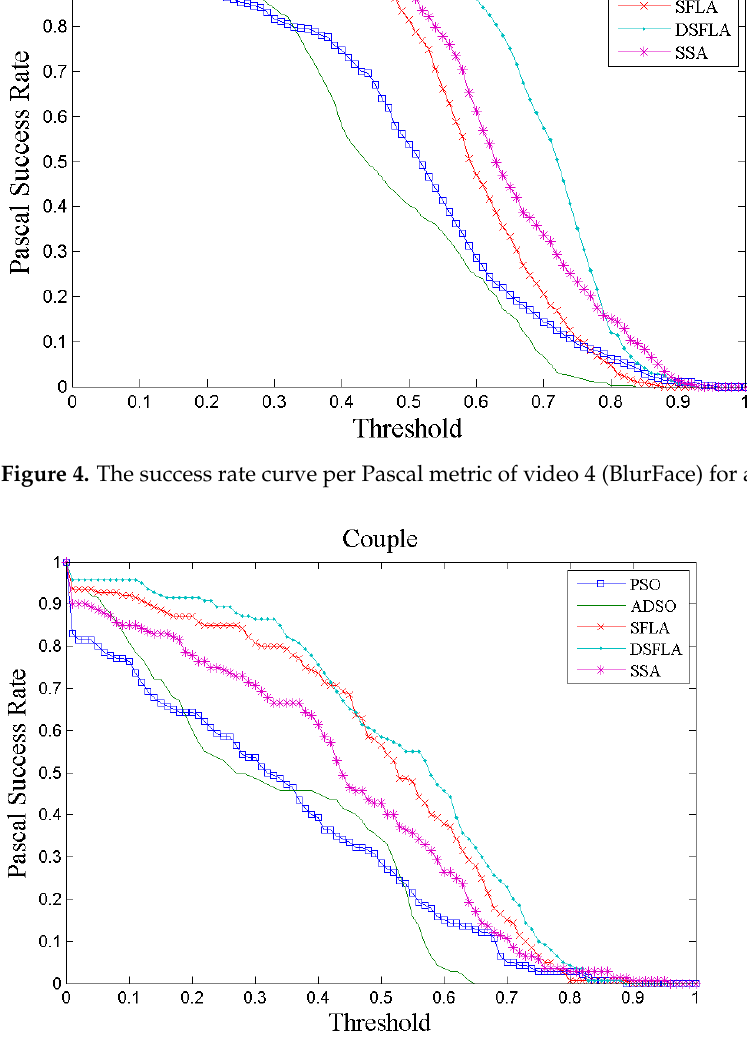
Figure 5. The success rate curve per Pascal metric of video 7 (Couple) for all trackers.